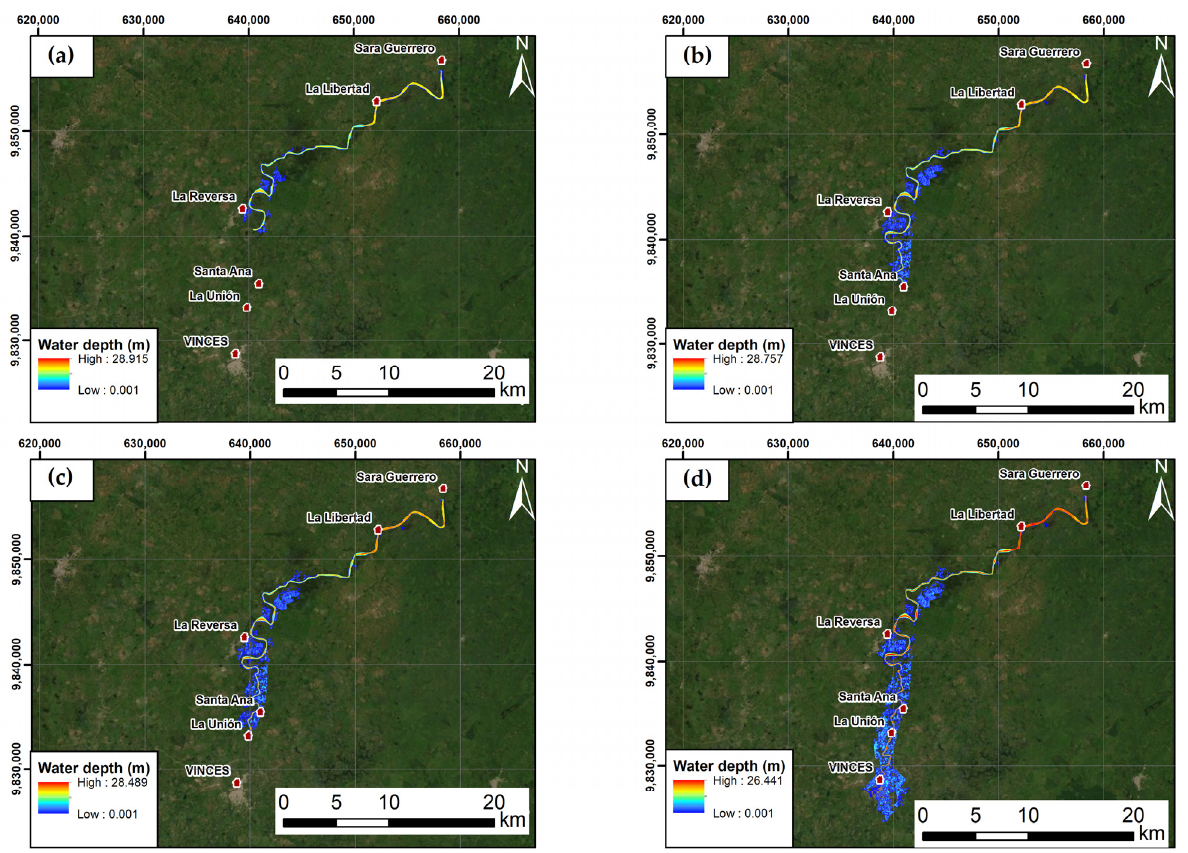
Figure 16. Flood propagation after the dam failure: ( a ) at 31 h; ( b ) at 37 h; ( c ) at 39 h; ( d ) at 48 h.